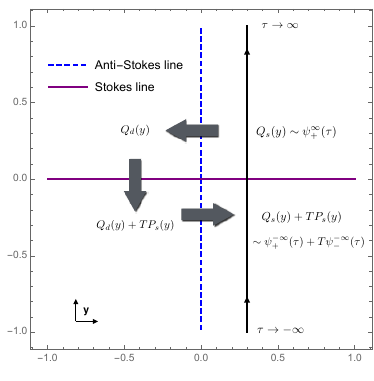
Figure 13 . Stoke’s phenomenon for the Whittaker